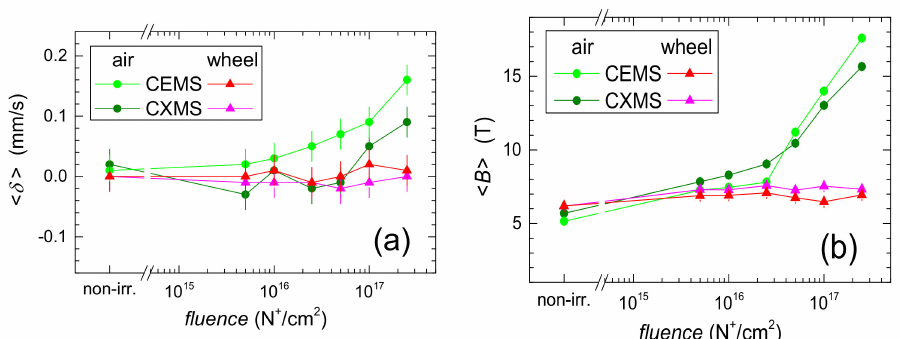
Figure 17. Parameters derived from CEMS and CXMS spectra recorded from the air (circles) and wheel (triangles) sides of 57 Fe 75 Mo 8 Cu 1 B 16 irradiated by 130 keV N + ions plotted against the ion fluence: ( a ) Average isomer shift, (cid:104) δ (cid:105) ; ( b ) average hyperfine magnetic field, (cid:104) B (cid:105) . Solid lines are only guides for the eye.